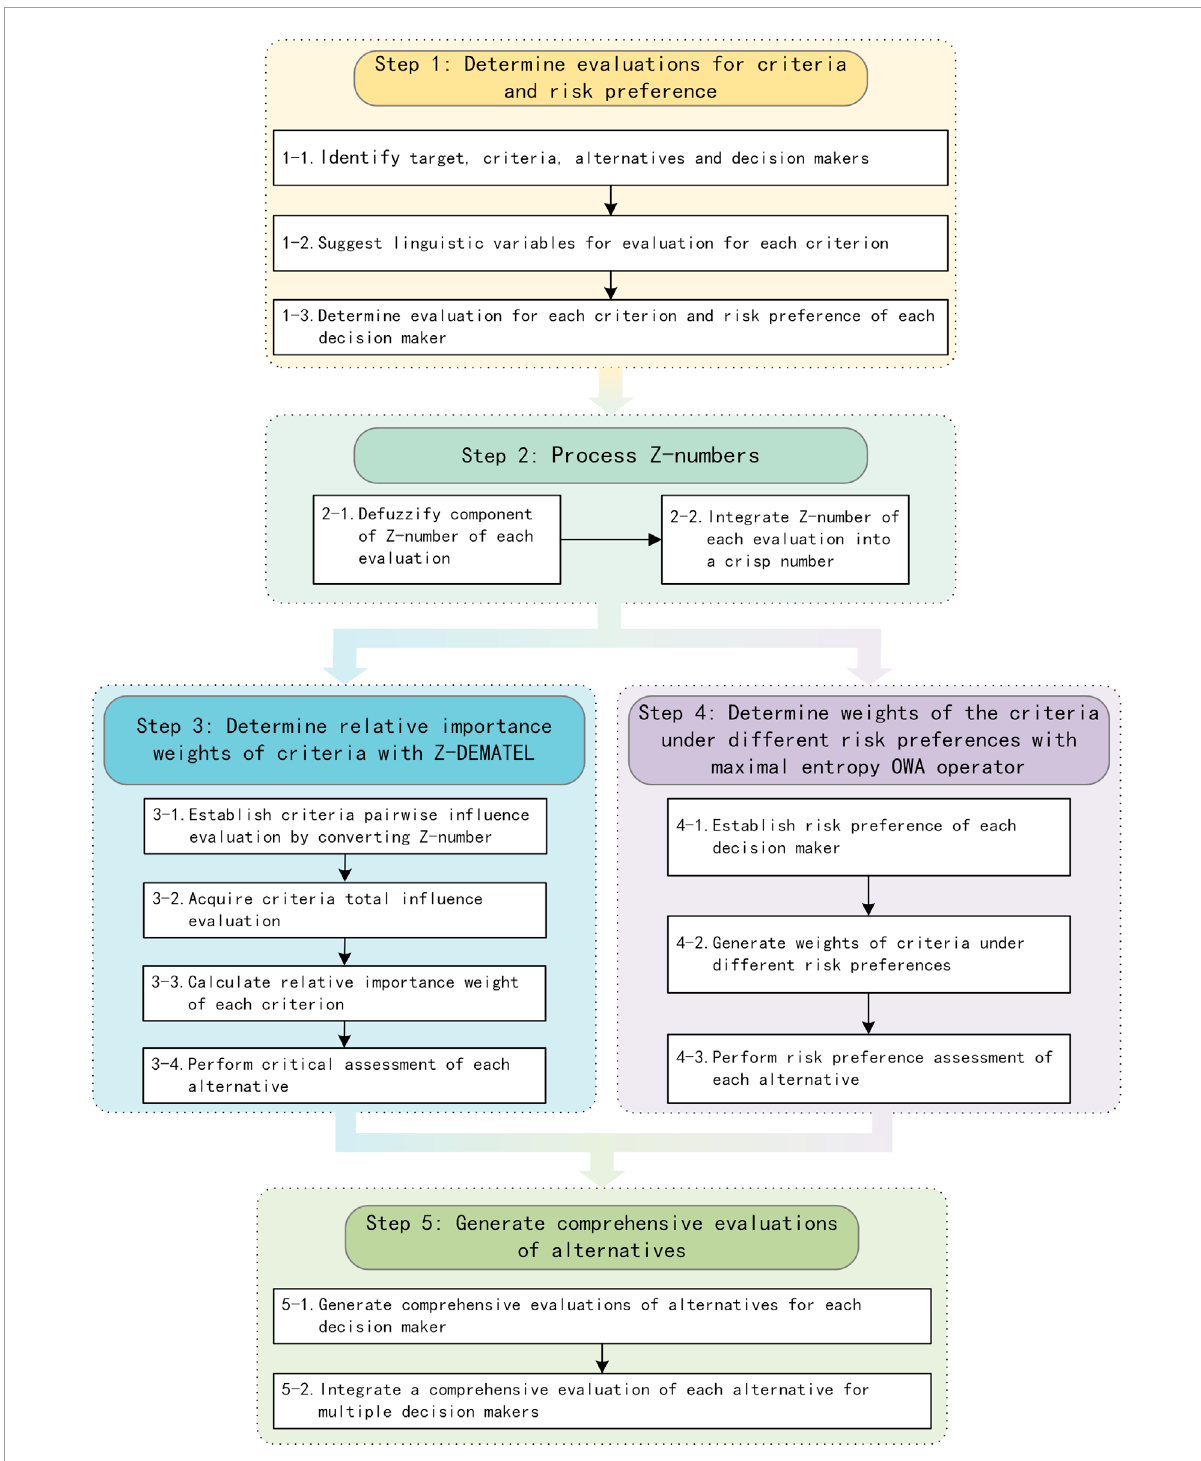
FIGURE 2 Framework of the proposed